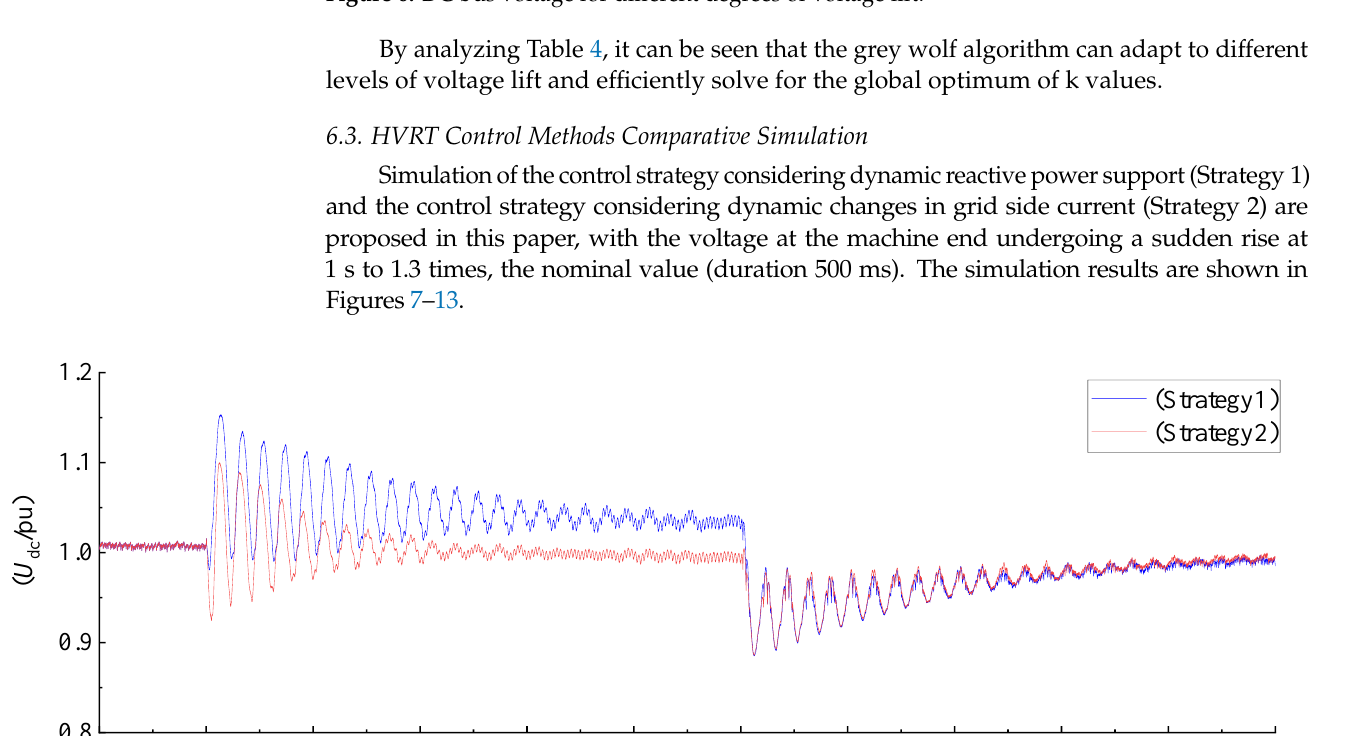
Figure 6. DC bus voltage for different degrees of voltage lift.